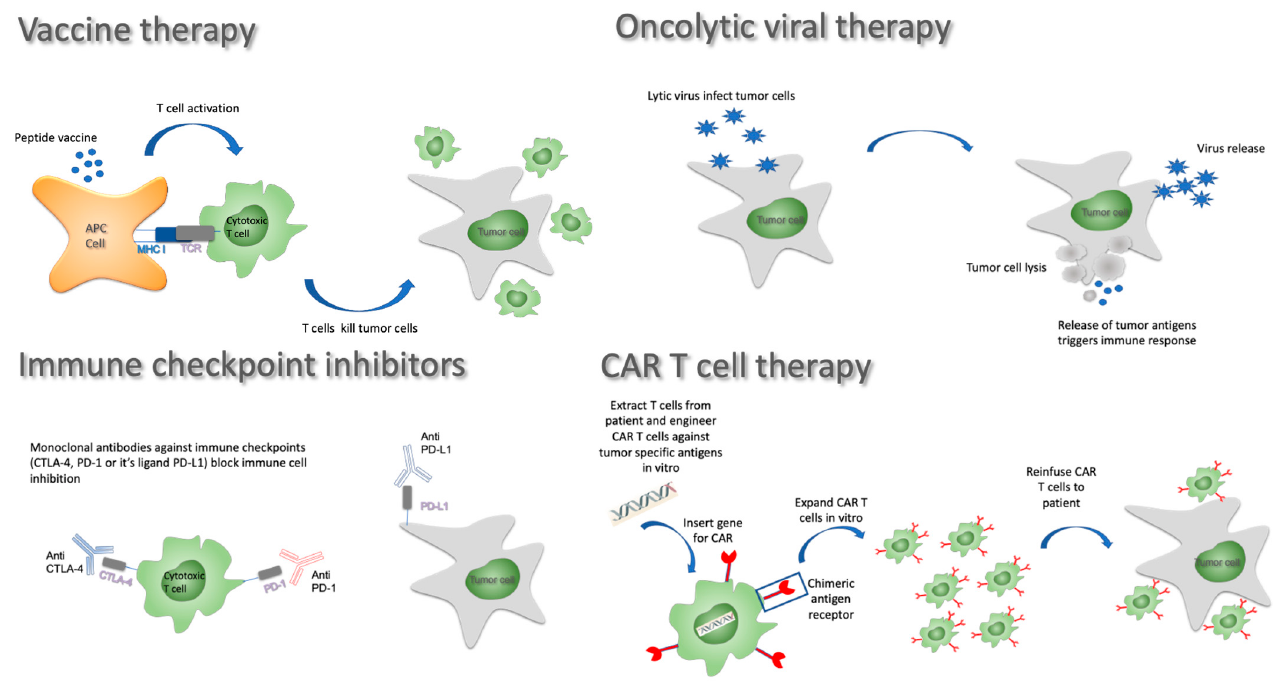
Figure 2. Immunotherapy approaches against GBM.